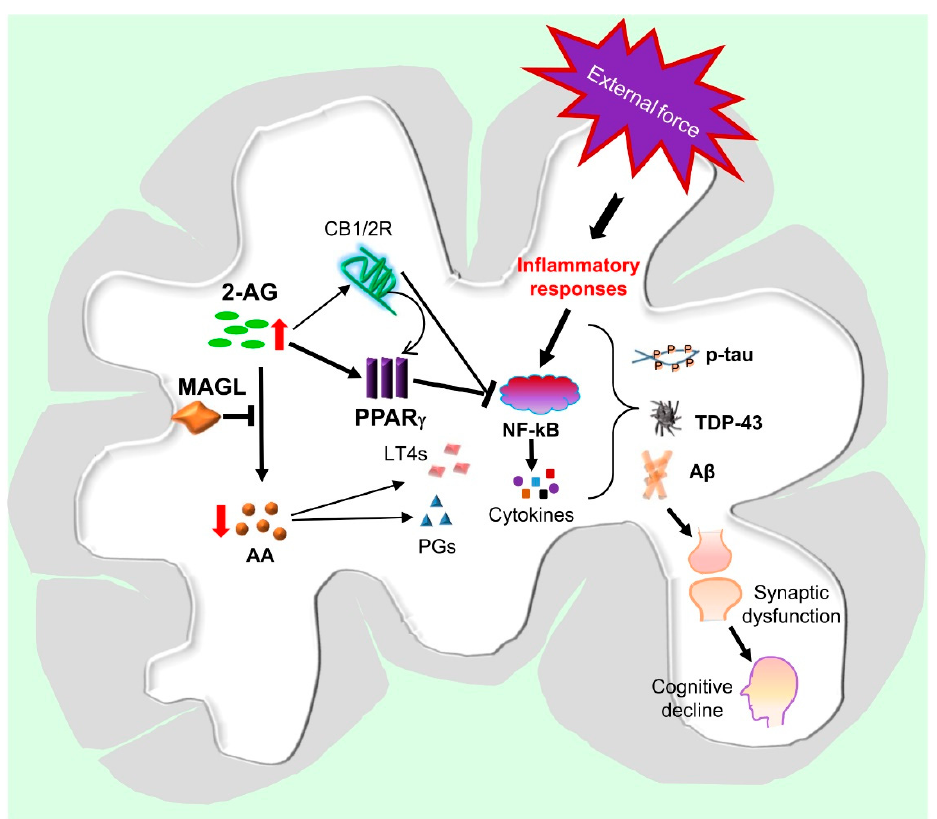
Figure 3. Hypothetic signaling pathways mediating neuroprotection produced by MAGL inactivation in TBI. An external force triggers the activation of inflammatory responses through NF-kB signaling in brain immune cells, including astrocytes and microglia, resulting in the release of chemokines, cytokines, and eicosanoids. These inflammatory factors promote tau phosphorylation, TDP-43 aggregation, and A β formation, leading to synaptic dysfunction and neurodegeneration, which, in turn, cause cognitive deficits and eventually lead to dementia. Inhibition of 2-AG metabolism by inactivation of MAGL augments the anti-inflammatory and neuroprotective 2-AG signaling, which stimulates the expression and activity of PPAR γ through CB1/2-dependent and-independent mechanisms. PPAR γ interacts with NF-kB to inhibit its transcriptional activity, resulting in decreases in the expression of genes involved in inflammatory and neurodegenerative processes. Inactivation of MAGL also reduces 2-AG metabolites, including arachidonic acid (AA), prostaglandins (PGs), and leukotrienes (LT4s), which are proinflammatory and neurotoxic. Resolution of neuroinflammation by inactivation of MAGL is likely a key to mitigate TBI-induced neuropathology and to improve synaptic and cognitive function.